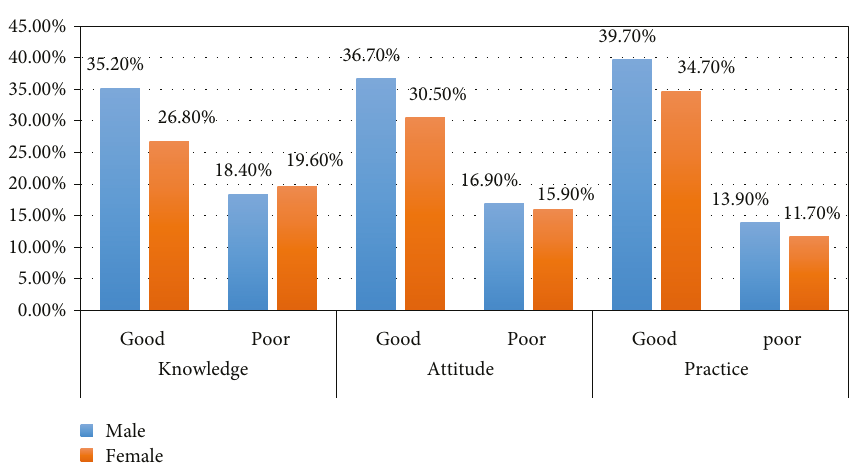
Figure 1: The level of KAP towards glycemic control by sex of DM patients at the University of Gondar Hospital, 2018. Table 5: Bivariant and multivariable analysis of factors associated with knowledge towards glycemic controls on DM patients at the University of Gondar referral hospital,